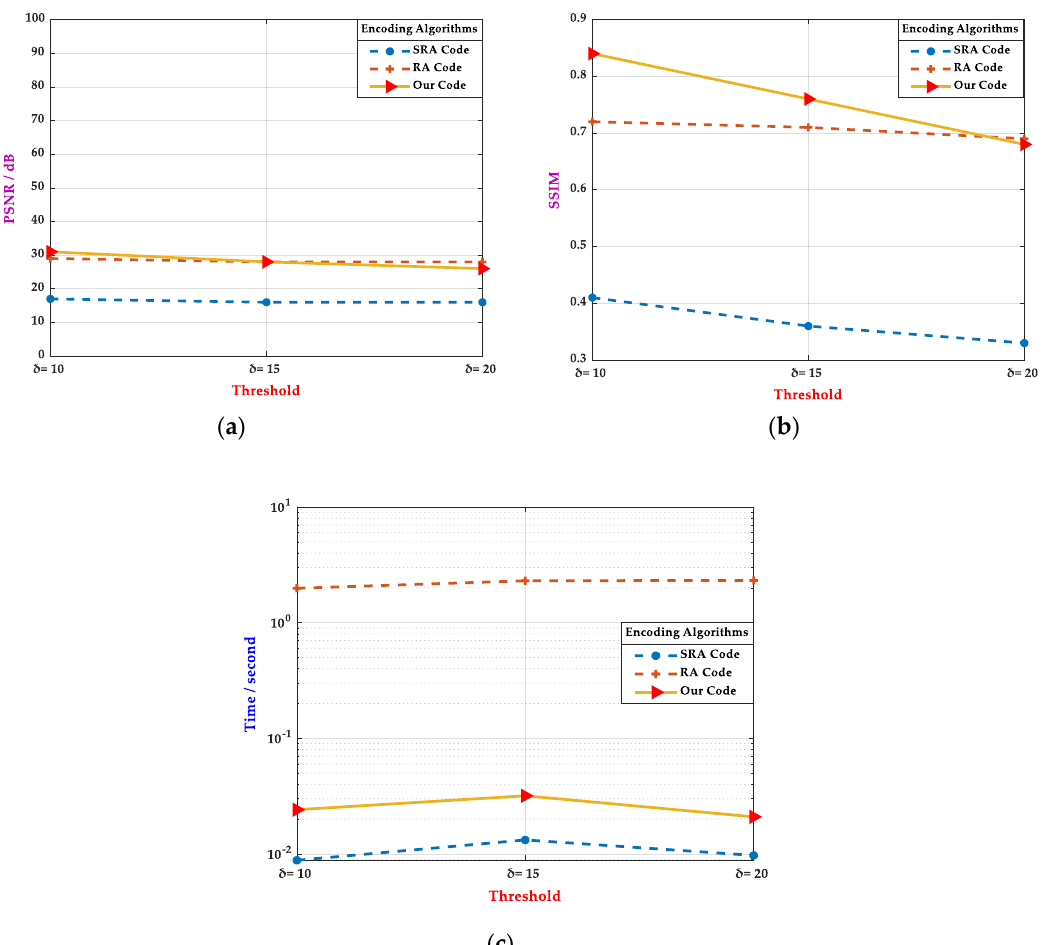
Figure 12. The perceptual quality and time consuming of various encoding algorithms under different thresholds. ( a ) The PSNR of various encoding algorithms under different thresholds. ( b ) The SSIM of various encoding algorithms under different thresholds. ( c ) The time consumed by various encoding algorithms under different thresholds.